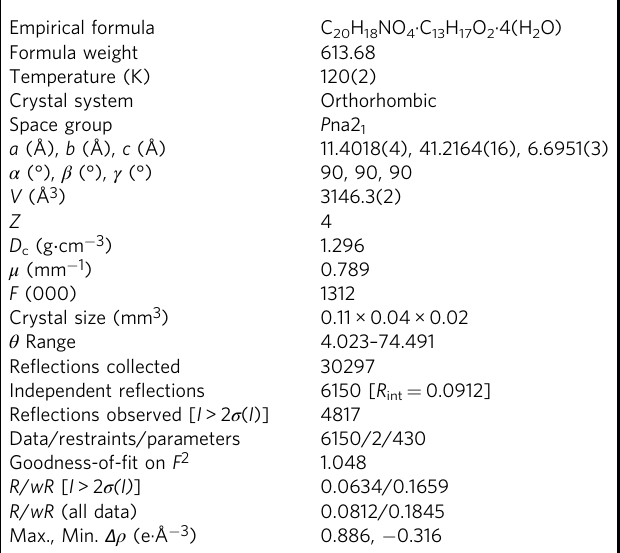
Table 1 Crystal data and structure re fi nement for BJ. Empirical